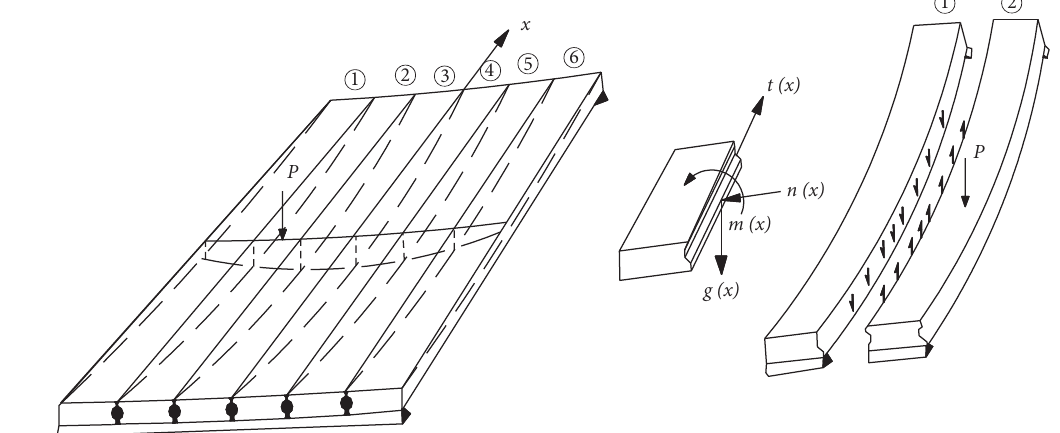
Figure 3: Stress diagram of adjacent beam Table 1: Dimensions of a design prototype and a model bridge beam.